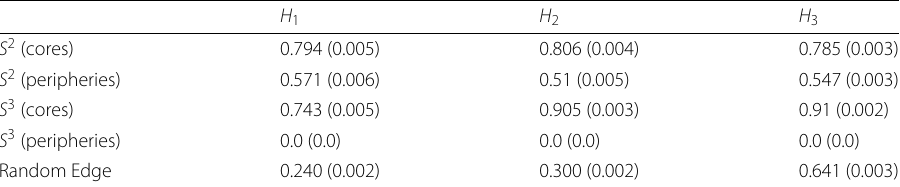
Table 2 Probabilities and standard errors for edges in the cores and peripheries of stars and of a random edge to be in H k H 1 H 2 H 3 S 2